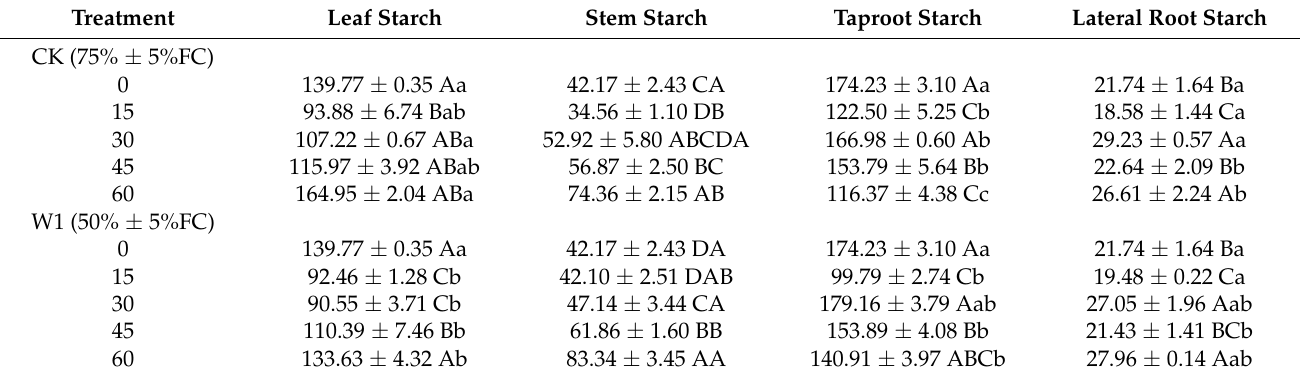
Table 2. The starch content of Mongolian oak seedlings in leaves, stems, taproots, and lateral roots under different drought intensities and